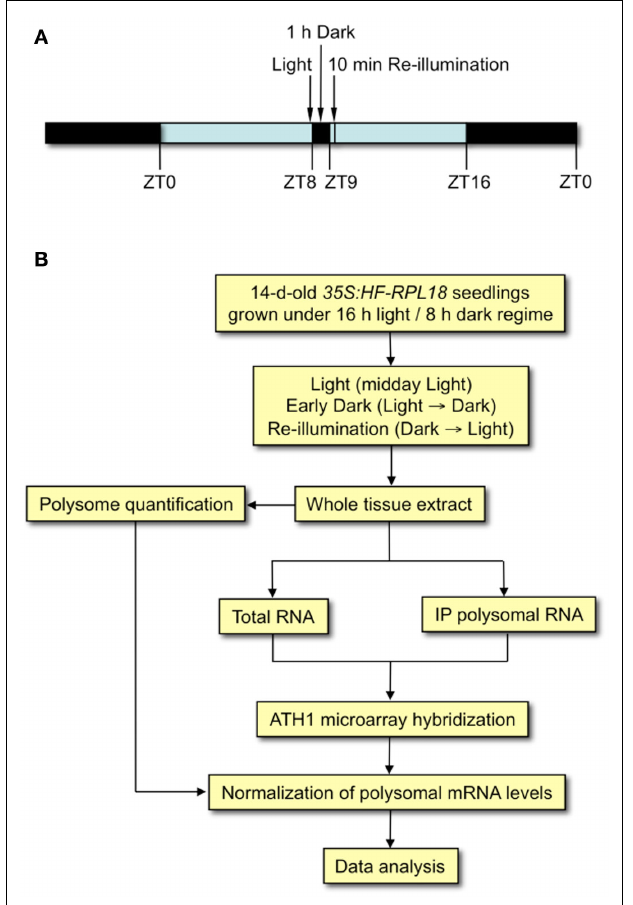
FIGURE 1 | Quantitative analysis of the molecular response to the shift to early darkness and re-illumination in Arabidopsis (Col-0) seedlings. (A) Experimental scheme of the light cycle used for seedling growth for 14days on MS medium supplemented with 1% (w/v) sucrose. Arrows indicate time of day relative to the beginning of the light period (ZT0). Light (control) seedlings were harvested in the light at ZT9, Early Dark seedlings were transferred to darkness at ZT8 for 1h and harvested, and Re-illumination seedlings were transferred to darkness at ZT8 for 1h and then re-illuminated for 10min before harvest. (B) Flow diagram of experimental strategy for quantitative assessment of transcript abundance in the total mRNA and immunopurified polysomal mRNA populations.